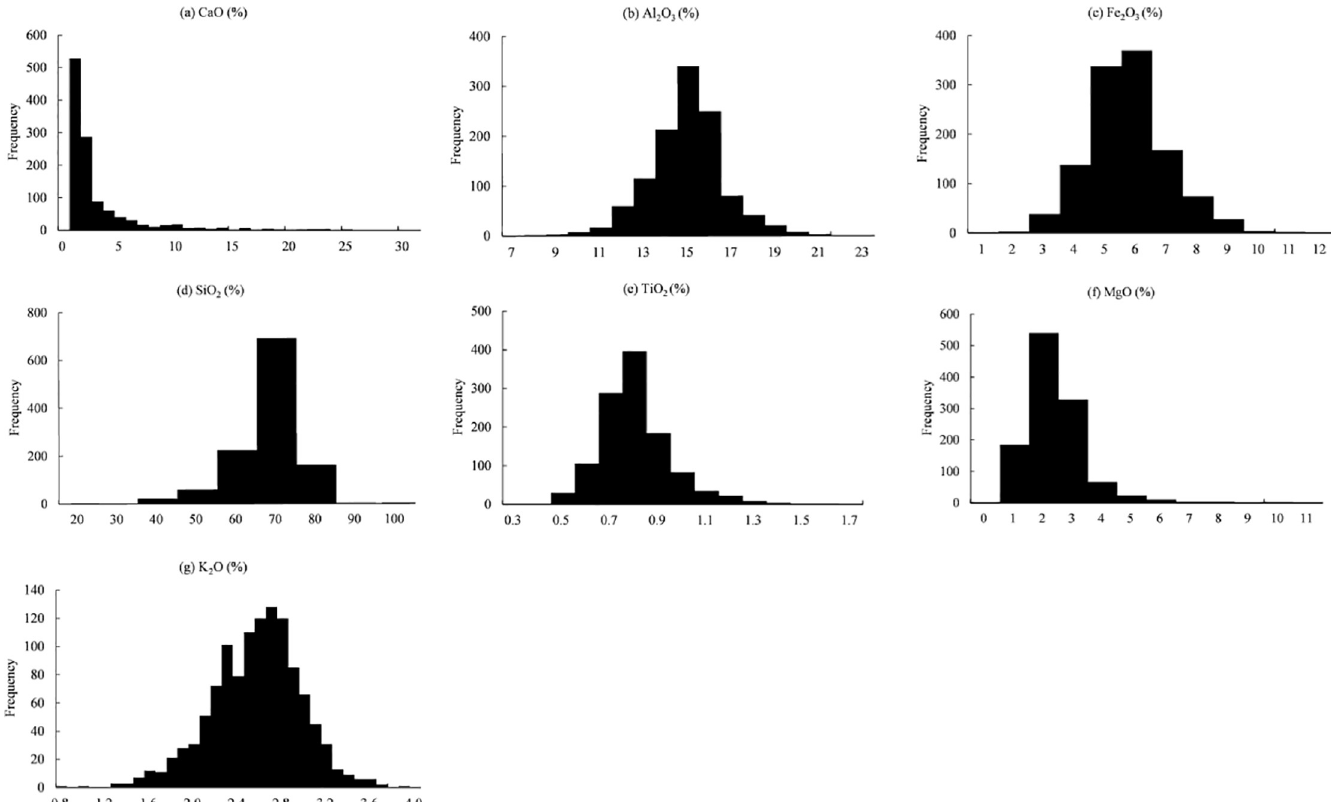
Fig 3. Histogram plots for the geochemical